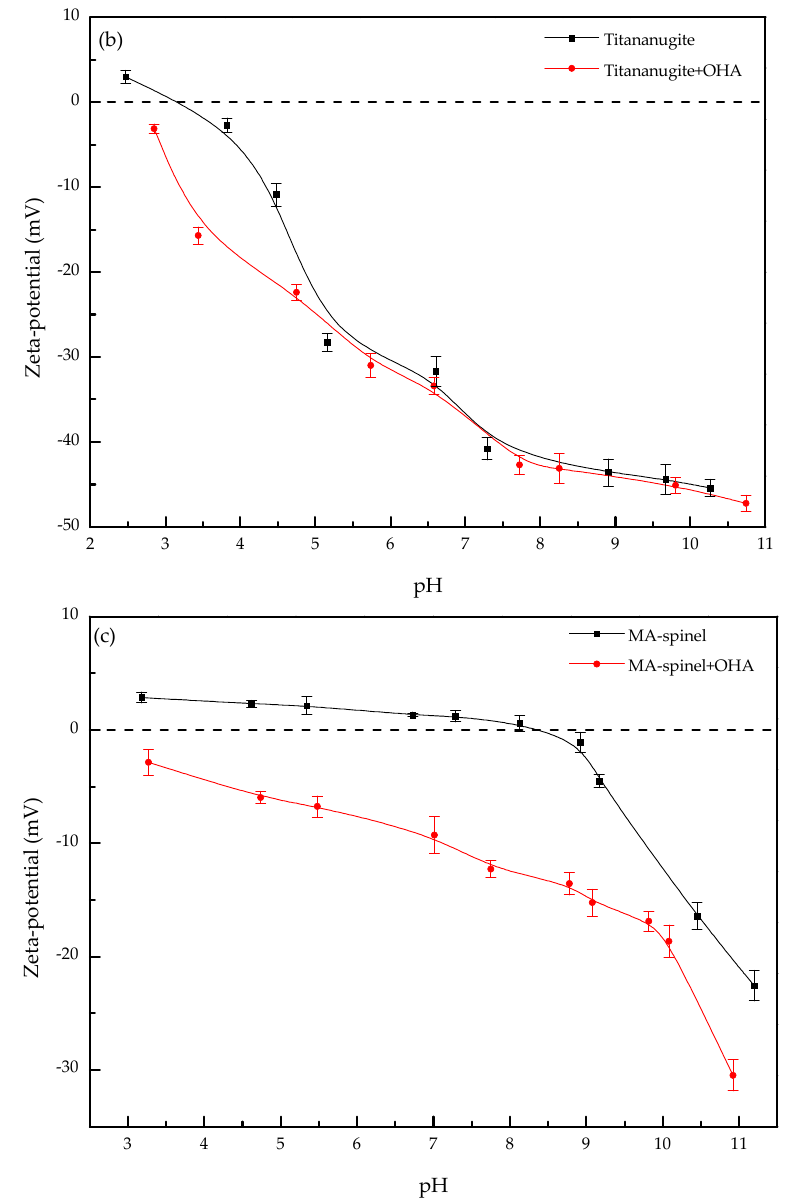
Figure 6. Zeta-potentials of perovskite ( a ), titanaugite ( b ), and MA-spinel ( c ) functions of pH in the absence and presence of OHA ( c OHA = 1.5 × 10 − 4